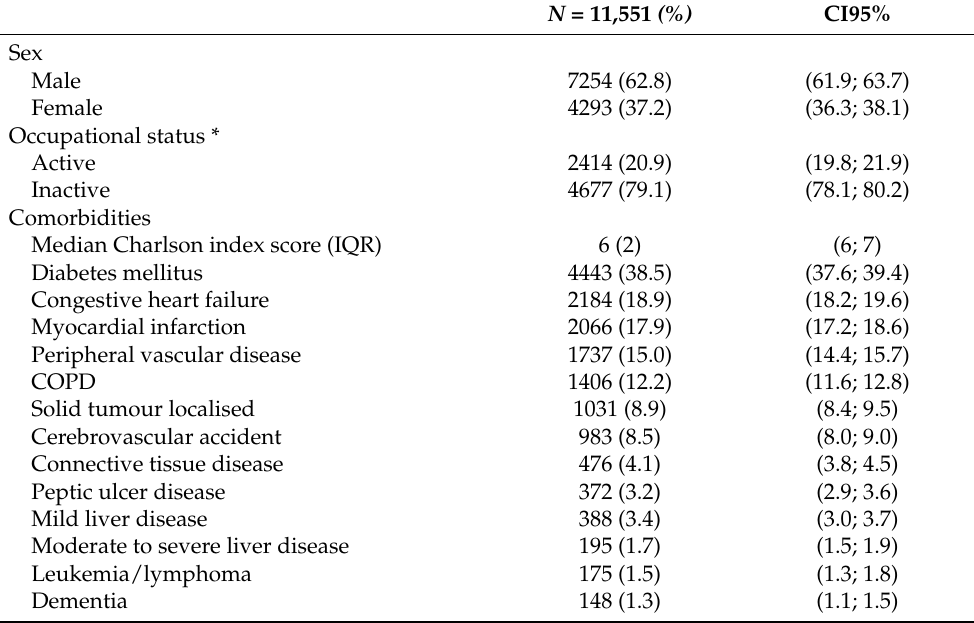
Table 1. Demographic, clinical, and follow-up characteristics of the patients included in the cohort. N = 11,551